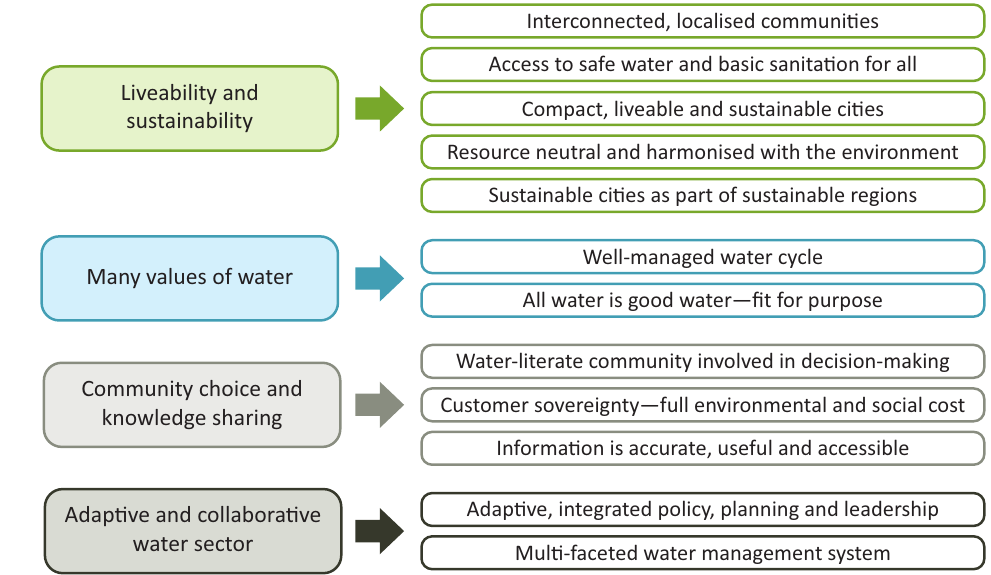
Figure 1. Principles for a City of the Future. Source: Wong et al. (2013, p. 8). Urban Planning, 2021, Volume 6, Issue 4, Pages